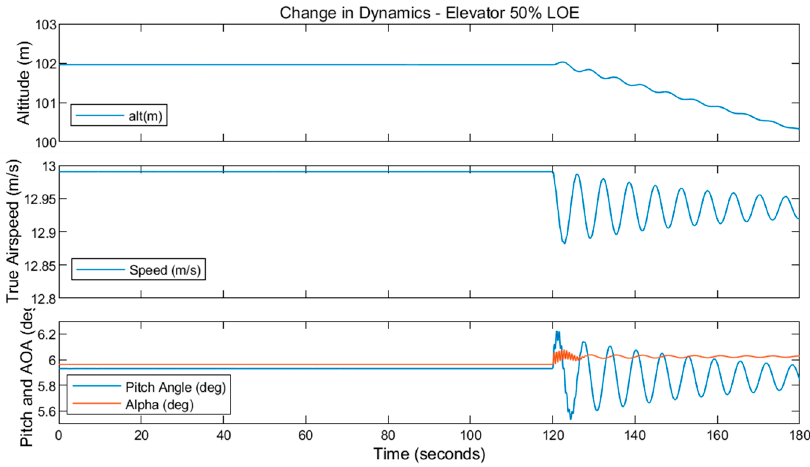
Figure 8. Accelerations in the body axis for the elevator 50% LOE fault.